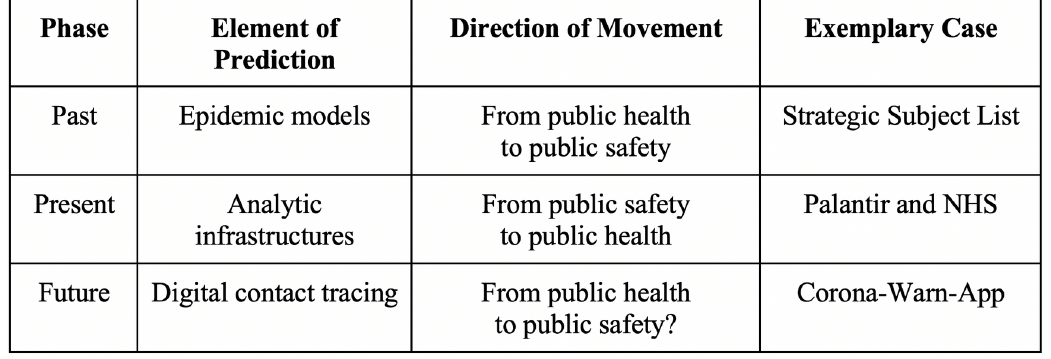
Table 1: Three waves in the movement of prediction